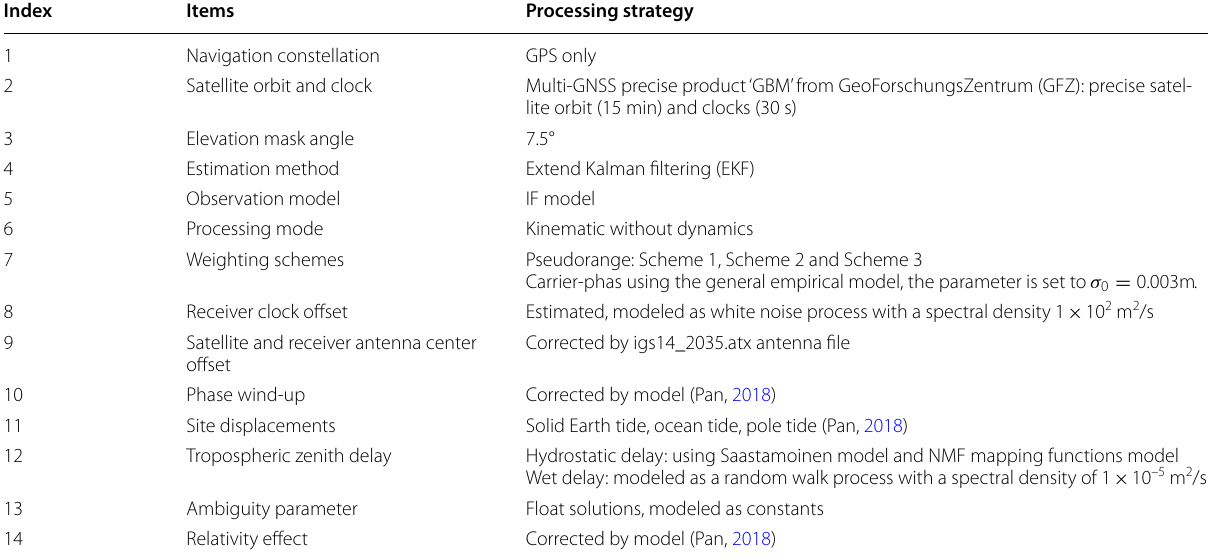
Table 1 PPP processing strategy and models (Elmezayen and EI-Rabbany 2020)